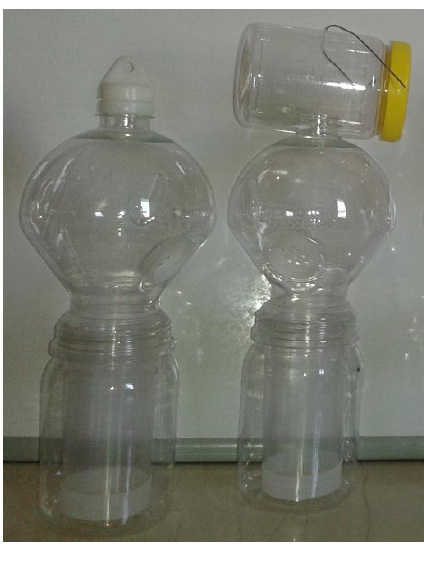
Figure 8. Traps used to capture alive B. oleae adults from olive trees. A typical olive-fly trap ( Left ); A custom-made trap with a second room attached ( Right